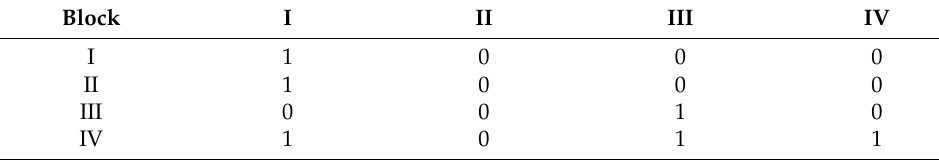
Table 4. Similarity